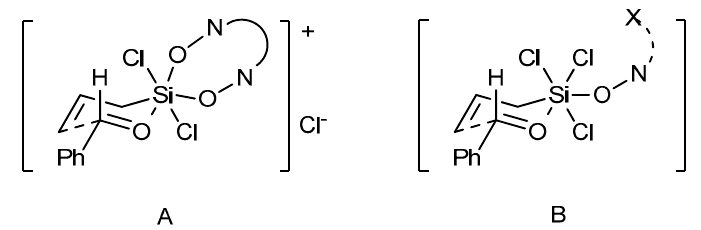
Figure 6. Envisioned transition states in the N- oxide catalyzed allylation of aldehydes [44].